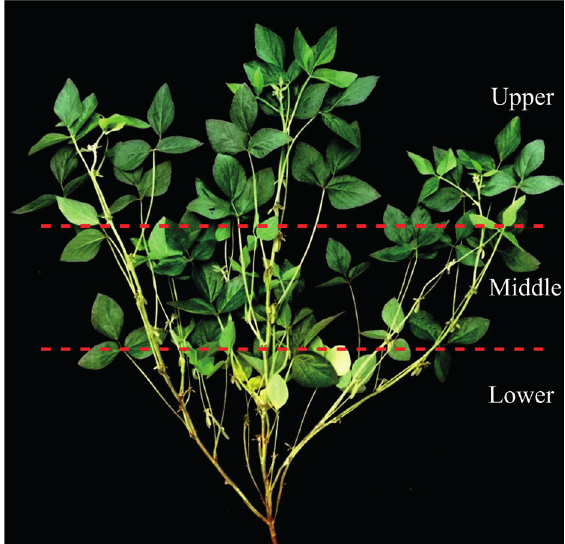
Figure 2 - Schematic of the separation of the plant canopy of soybean plants into upper, middle and lower leaf strata. Classifications are delineated by the two parallel